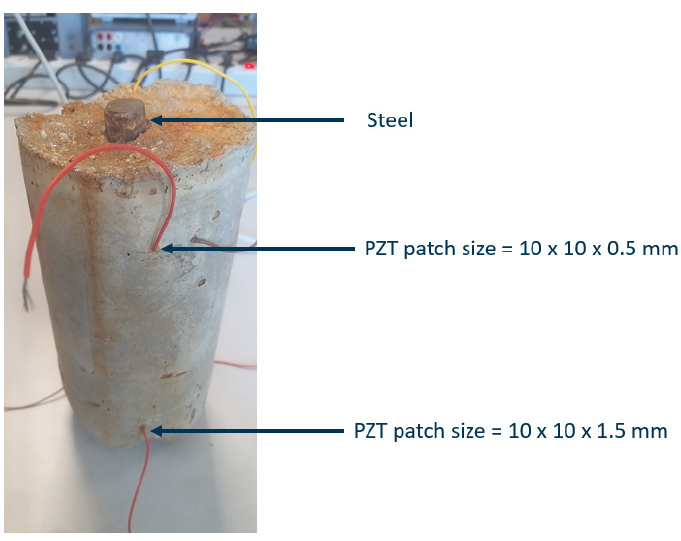
Figure 16. Corroded (20 cm long steel) reinforced concrete.